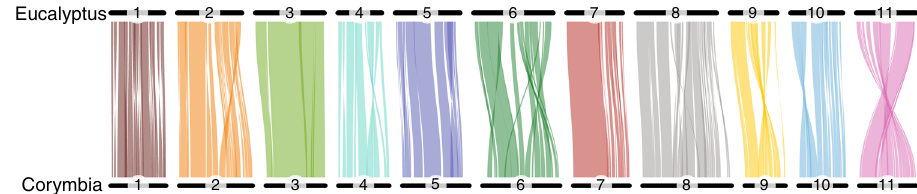
Fig. 3 Intra-chromosomal syntenic blocks among Eucalyptus grandis and Corymbia citriodora subsp variegata . Numbers represent individual chromosomes. Minimum number of genes per block is 25. Table 2 Comparison of chromosome gene content and synteny between Corymbia citriodora subspecies variegata and Eucalyptus grandis